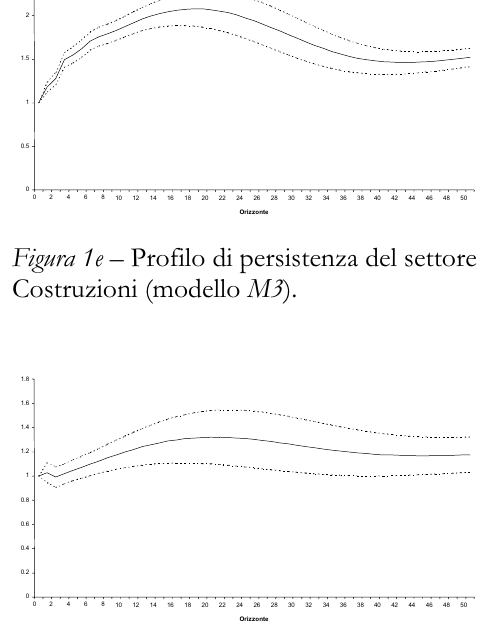
Figura 1h – Profilo di persistenza del settore Servizi Vendibili (modello M3